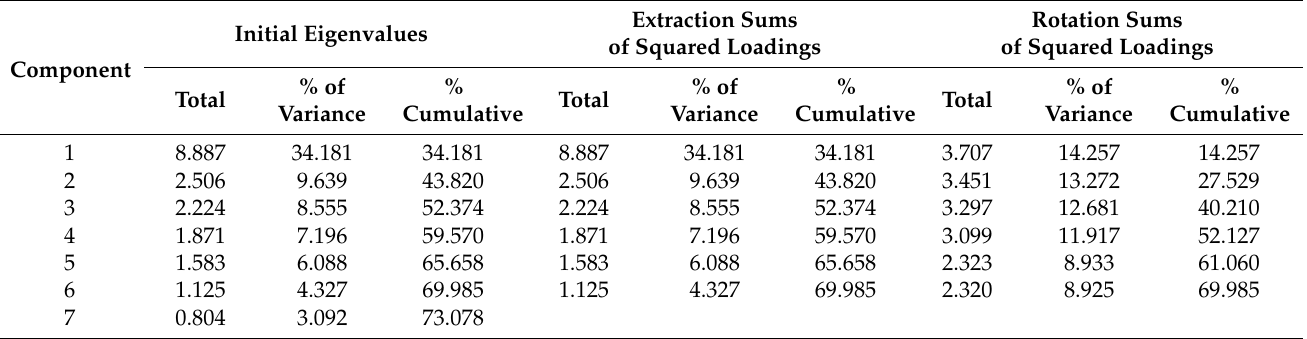
Table 4. Total variance explained by six factor extracted during Exploratory Factor Analysis